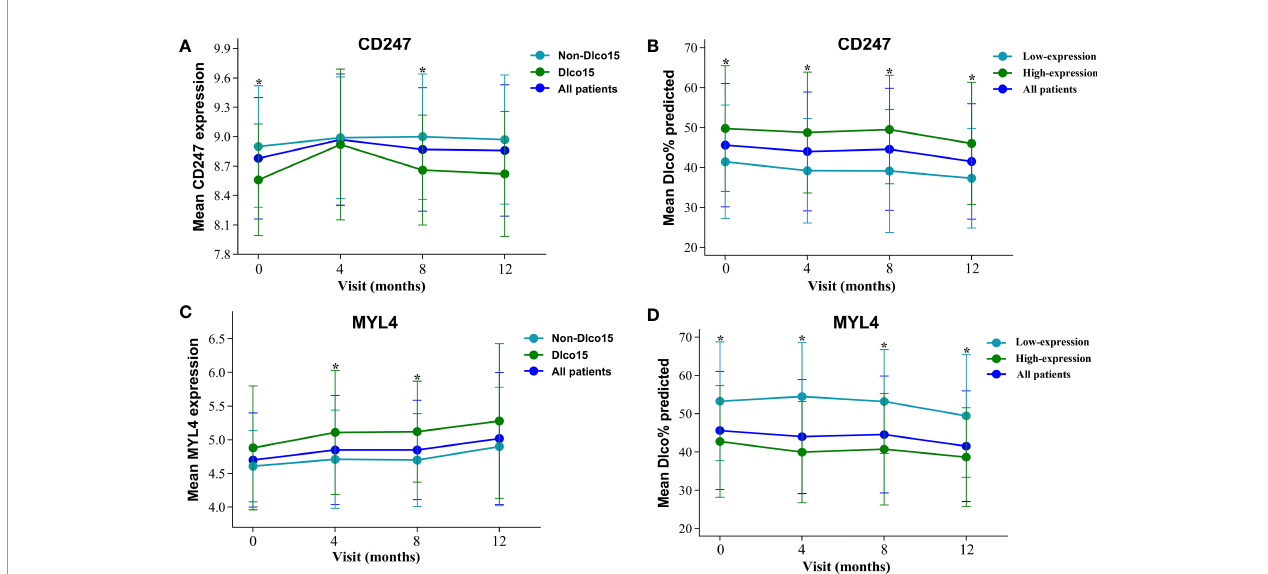
FIGURE 2 | The expression of CD247 and MYL4 and their value for Dlco% predicted after visiting at 0, 4, 8, and 12 months in the GSE132607 dataset. (A) The change of mean CD247 expression. (B) The comparison of mean Dlco% predicted between high-expression and low-expression CD247. (C) The change of mean MYL4 expression. (D) The comparison of mean Dlco% predicted between high-expression and low-expression MYL4. *p < 0.05.